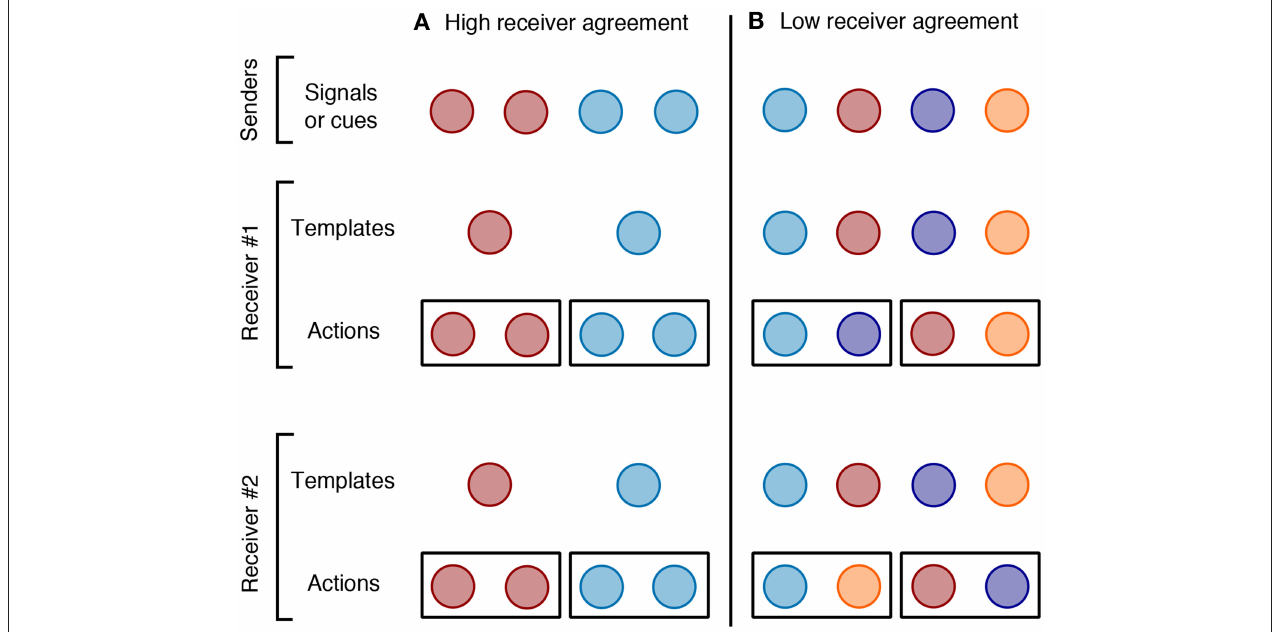
FIGURE 2 | The representation and grouping of sender phenotypes (colors) as (1) signals or cues produced by senders, (2) templates in a receiver’s nervous system, and (3) receiver actions (e.g., accept or reject). Each dot represents a hypothetical individual, different colors represent different phenotypic signals or cues used for recognition, and boxes surround individuals who are treated as belonging to the same social category by a receiver’s actions. (A) when receivers agree on category membership (e.g., sex recognition), senders share signals or cues associated with a certain category, and receivers possess one template per category that can be used to recognize any individual that they encounter who is expressing that signal or cue. Recognition is not dependent on receiver experience so all receivers should associate the same phenotypes with the same categories. (B) When receivers disagree on category membership (e.g., neighbor recognition), signals or cues and templates are individual-specific but actions need not be. Receivers in population can share the same categories but they disagree on who belongs in those categories so they must use individually-distinctive traits to assign senders to